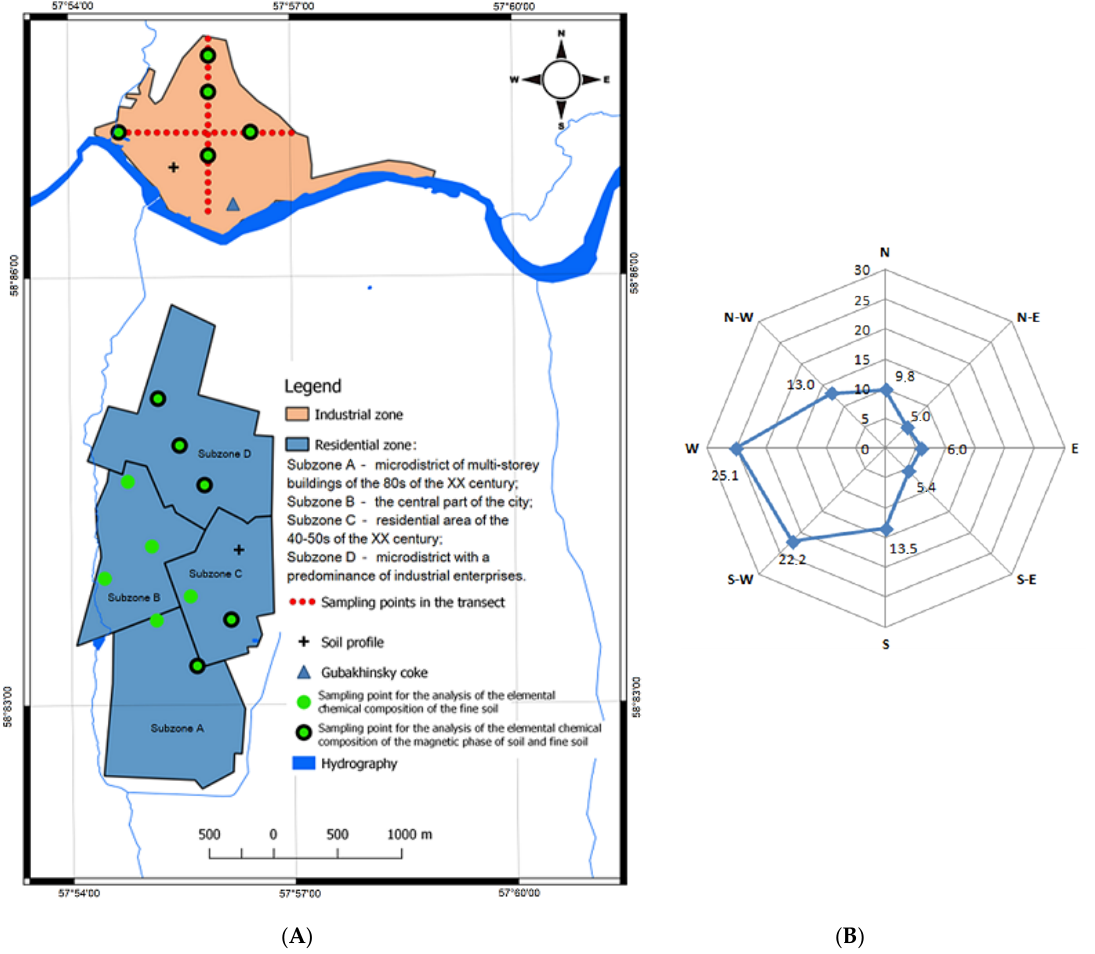
Figure 2. ( A ) Functional zoning scheme of the city territory. ( B ) Wind rose plot for Gubakha [121]. Quantities of 1.2–1.5 kg of wet mixed (combined) soil samples were taken for research. The samples were homogenized, had roots removed, air dried, crushed and sieved through a 1.0 mm sieve. Granulometric composition, physicochemical properties, elemental chemical composition and magnetic susceptibility were determined for soil samples with particle size <1.0 mm.